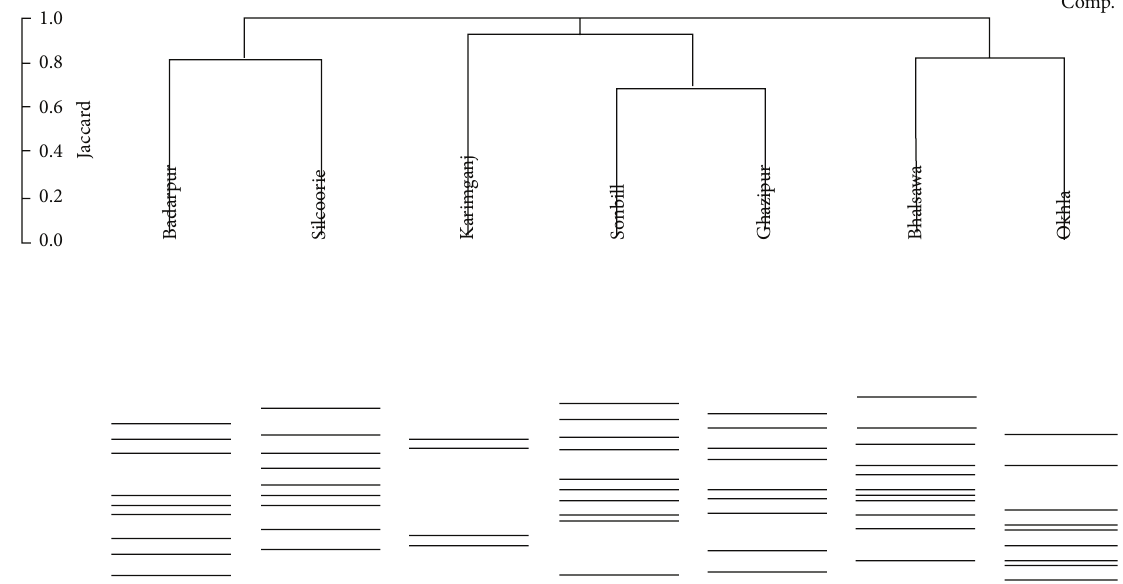
Figure 3: Jaccard cluster diagram of DGGE bands obtained from landfill sites of Delhi and marshland of Southern Assam, India.